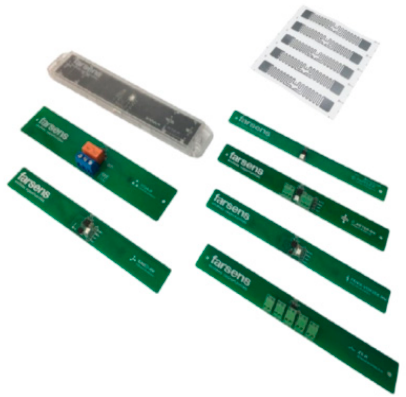
Figure 3. Wireless and battery-free sensors from Farsens.